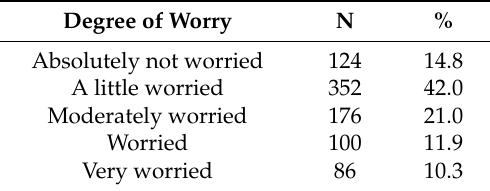
Table 3. Prevalence of different degrees of worrying about suffering workplace violence ( N = 838).